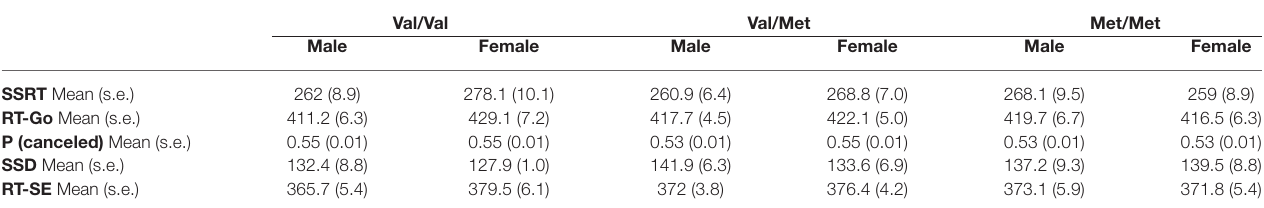
TABLE 2 | Descriptive statistics of the behavioral performance for each experimental group . Val/Val Val/Met Met/Met Male Female Male Female Male